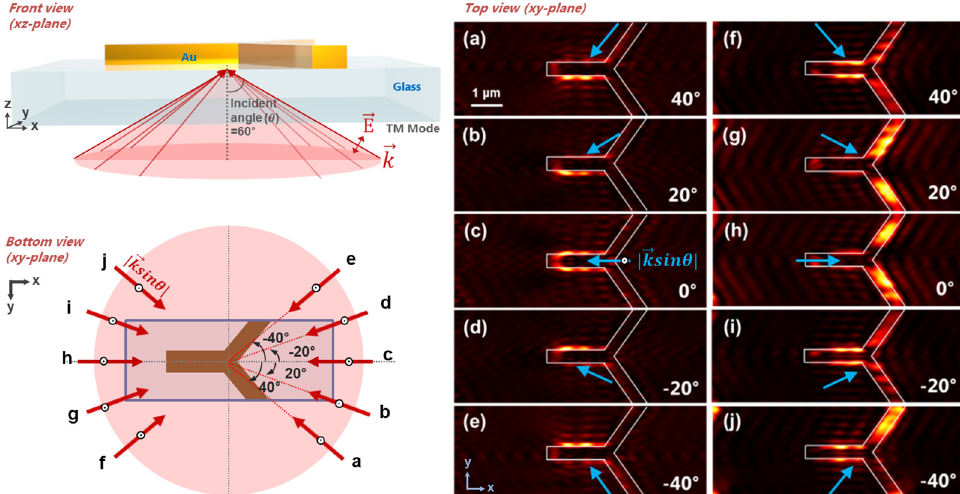
Figure 6. The effects of the incident light source orientation while maintaining TM mode and the incident angle as 60°. The schematic images of the front and bottom views are shown on the left. In the bottom view, the thick red arrows with respect to the direction of the incident light source and the black of the lowercase label identify the direction of the incident angle on the xy-plane and match the calculation results on the right side marked with the same label ( a – j ). In the calculation data, the angle written in white indicates the orientation of the incident light source in xy-plane which measured from horizontal x -axis.